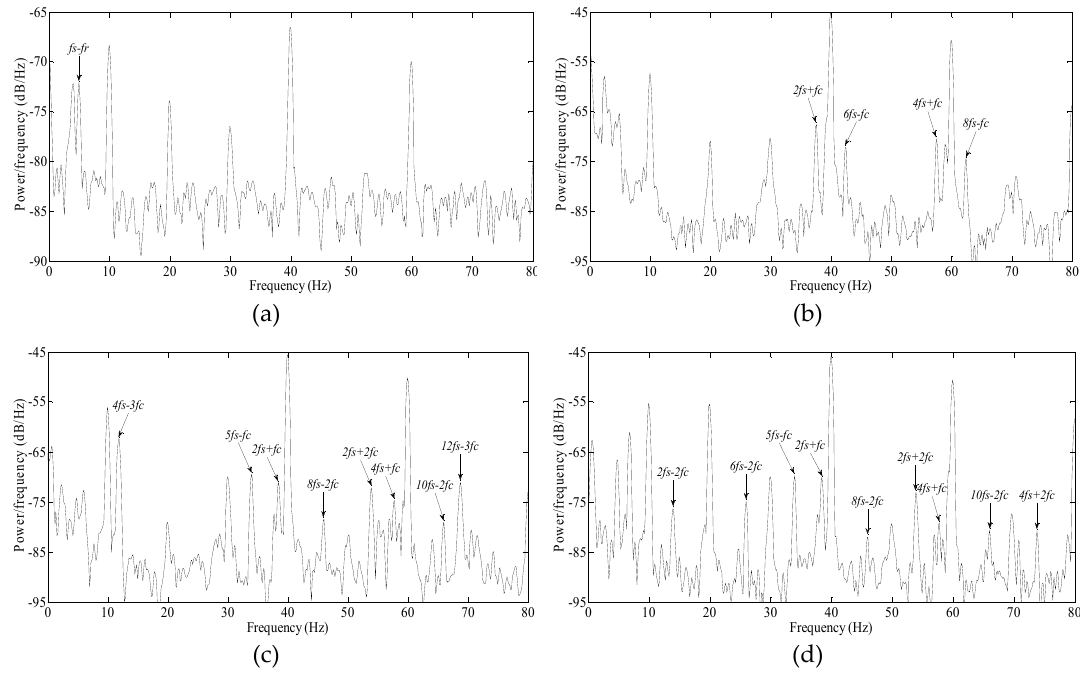
Figure 17. The squared envelope spectra for normal bearings and faulty bearings with various spall lengths: ( a ) normal bearing; ( b ) Δ Φ d =5°; ( c ) Δ Φ d =10°; ( d ) Δ Φ d =15°.